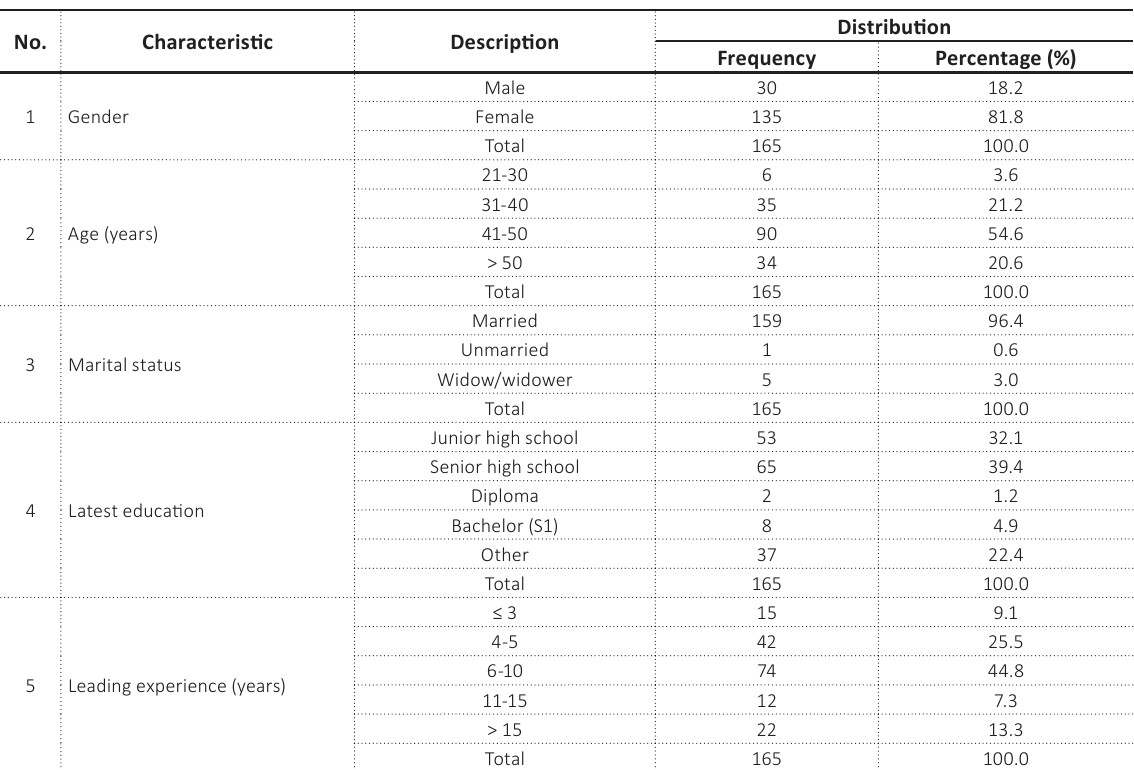
Table 2. Respondents’ general description